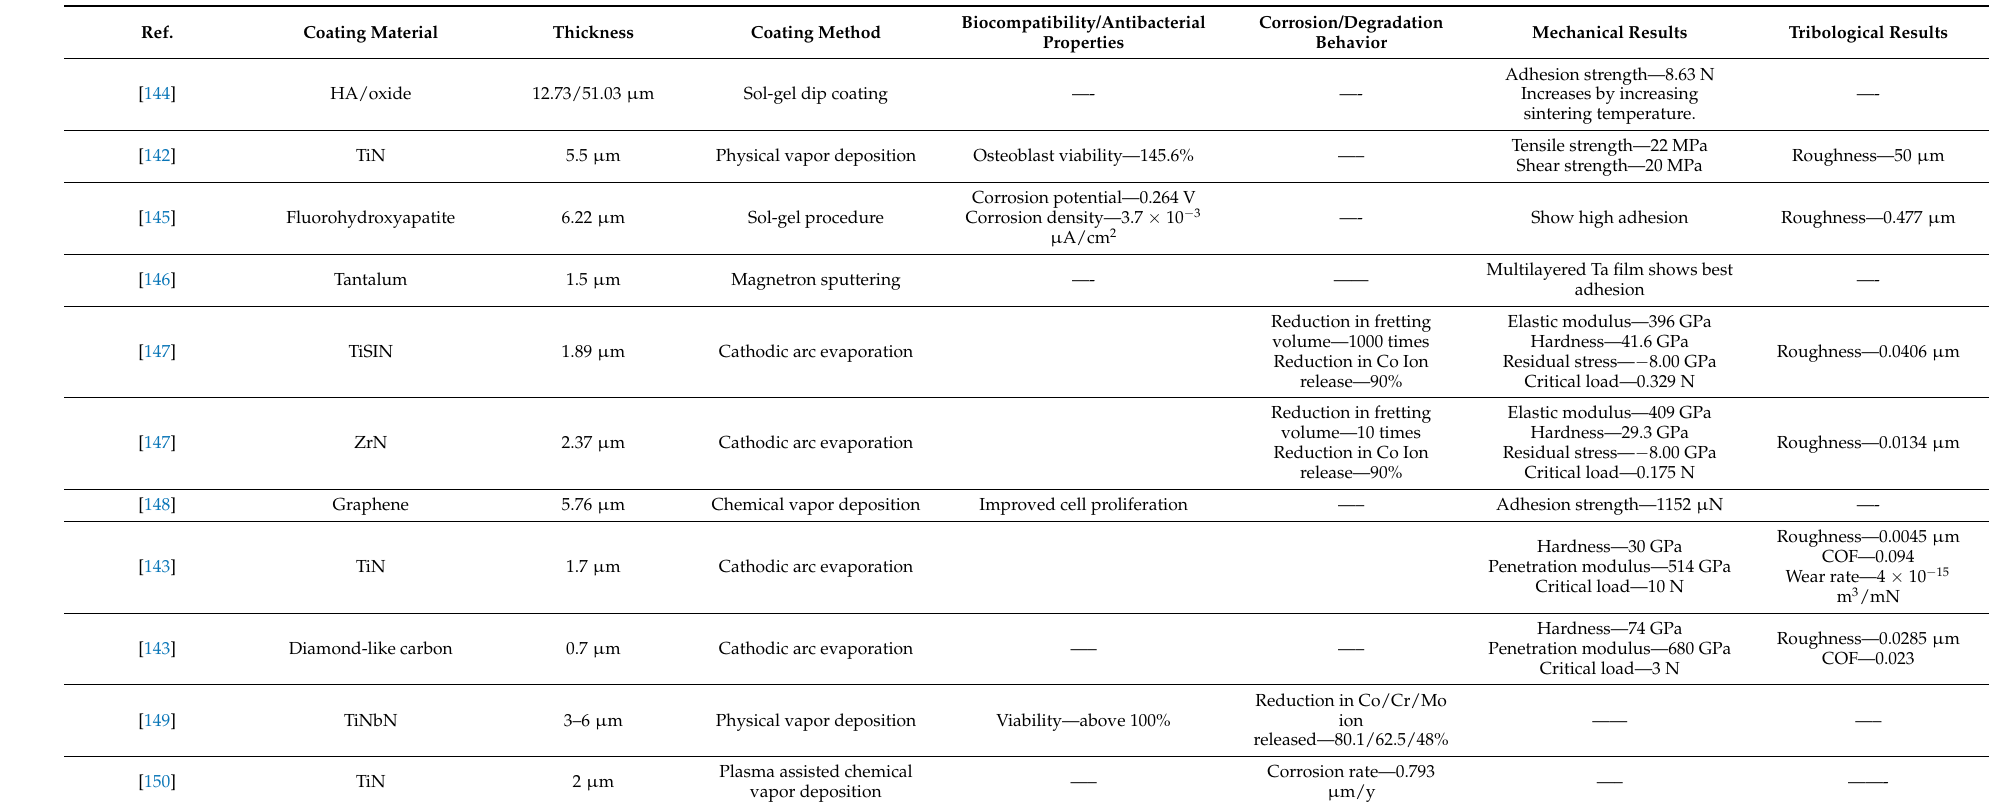
Table 5. Summary of results for CoCrMo